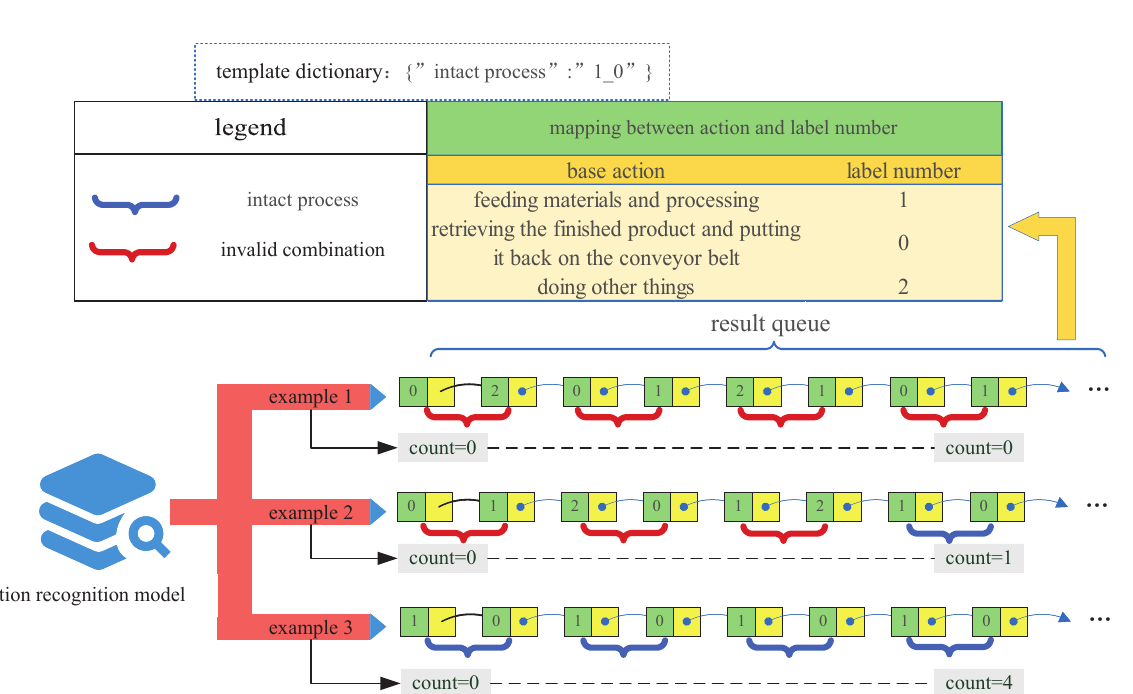
Figure 3. Schematic diagram of counting